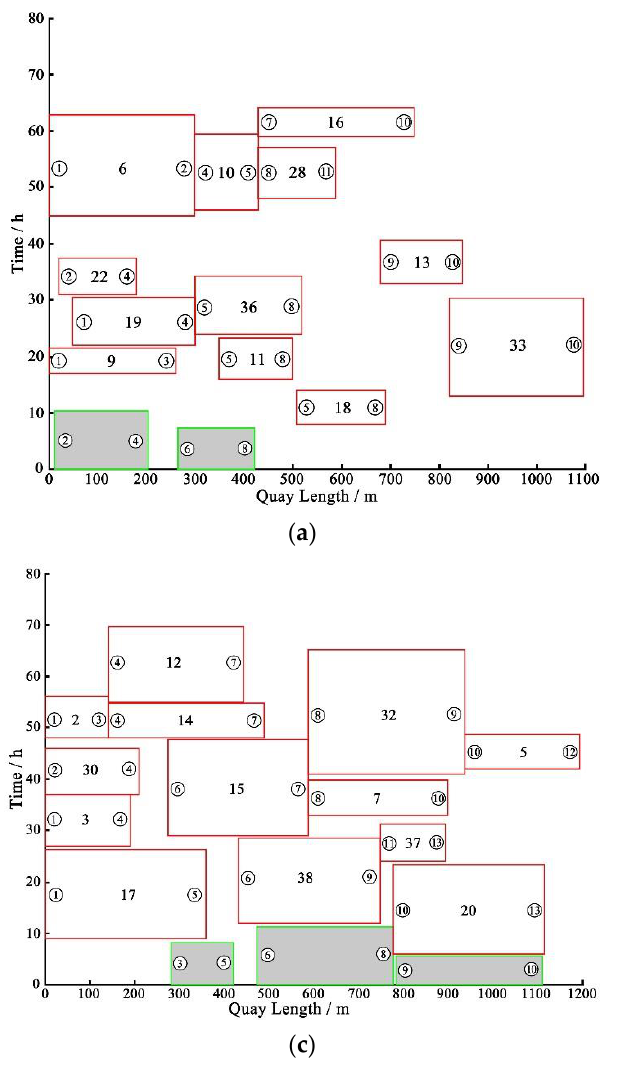
Figure 10. The scheduling solution under M + U. ( a ) terminal 1; ( b ) terminal 2; ( c ) terminal 3. (Source: compiled by authors).